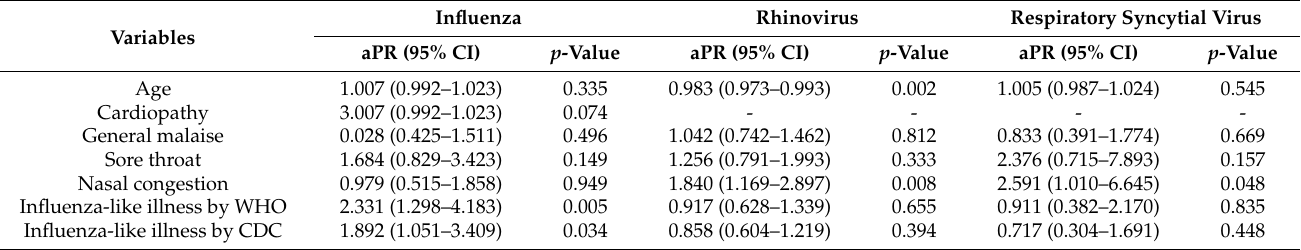
Table 4. Main clinical characteristics in relation to the pathogens detected. This table shows the Poisson regression analysis to evaluate adjusted prevalence ratio of respiratory